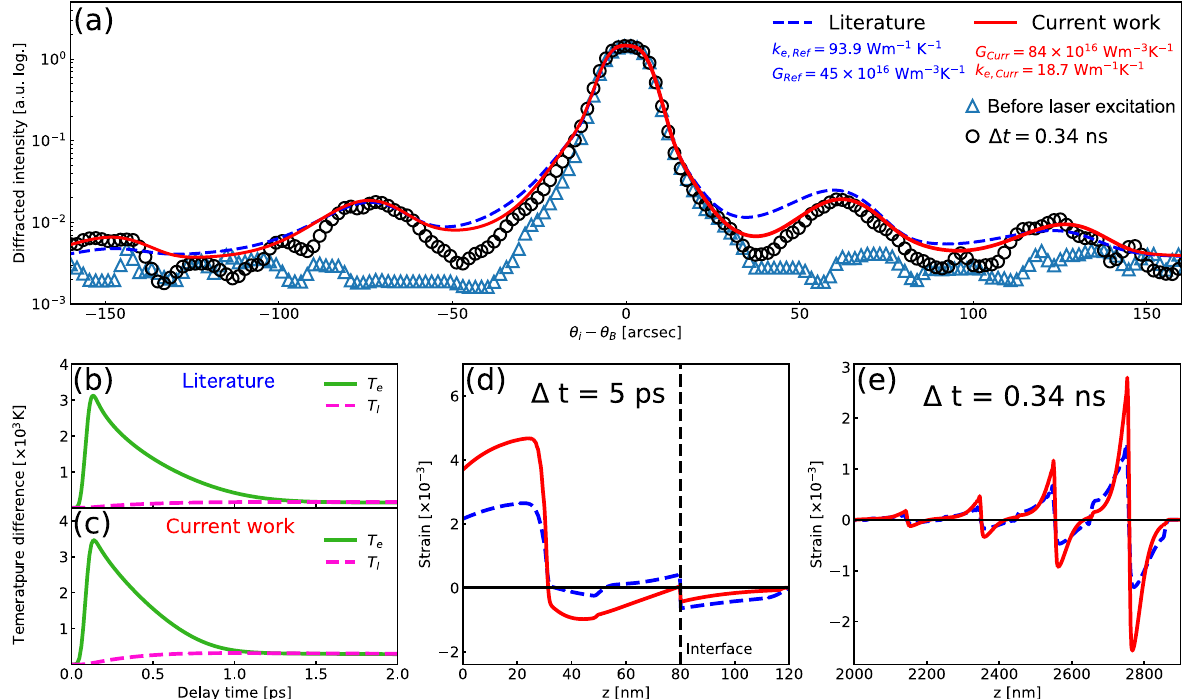
Figure 2. ( a ) Si (004) rocking curve (black circle) and calculation result of dynamical diffraction theory (blue dashed and red solid lines based on the literature values for G and k e and current work). The two temperature model for electron temperature ( T e ) and lattice temperature ( T l ) following laser excitation are shown for the literature values ( b ) and the current work ( c ). The calculated strain profiles for both the literature values (dashed blue) and current work (red solid) were solved at (cid:31) t = 5 ps ( d ) and at (cid:31) t = 0.34 ps ( e